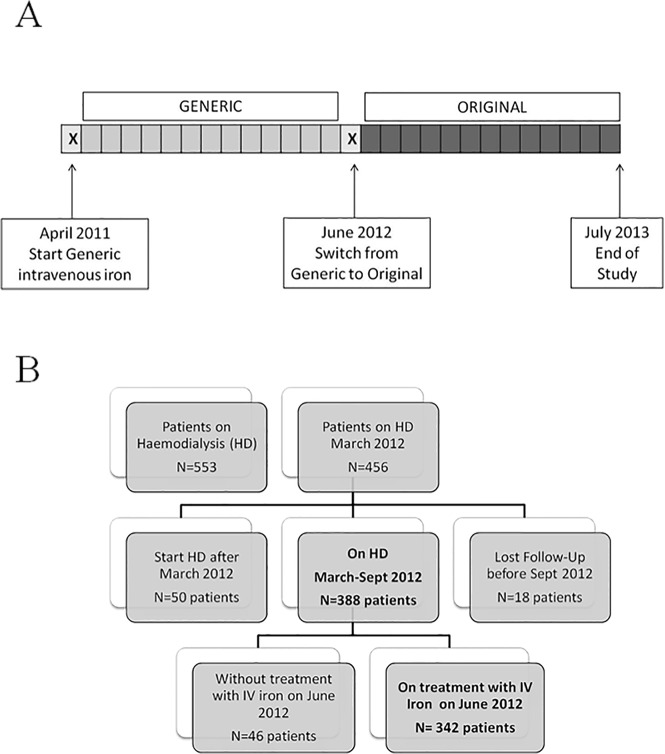
Study design (1A) and algorithm of study population selection (1B).